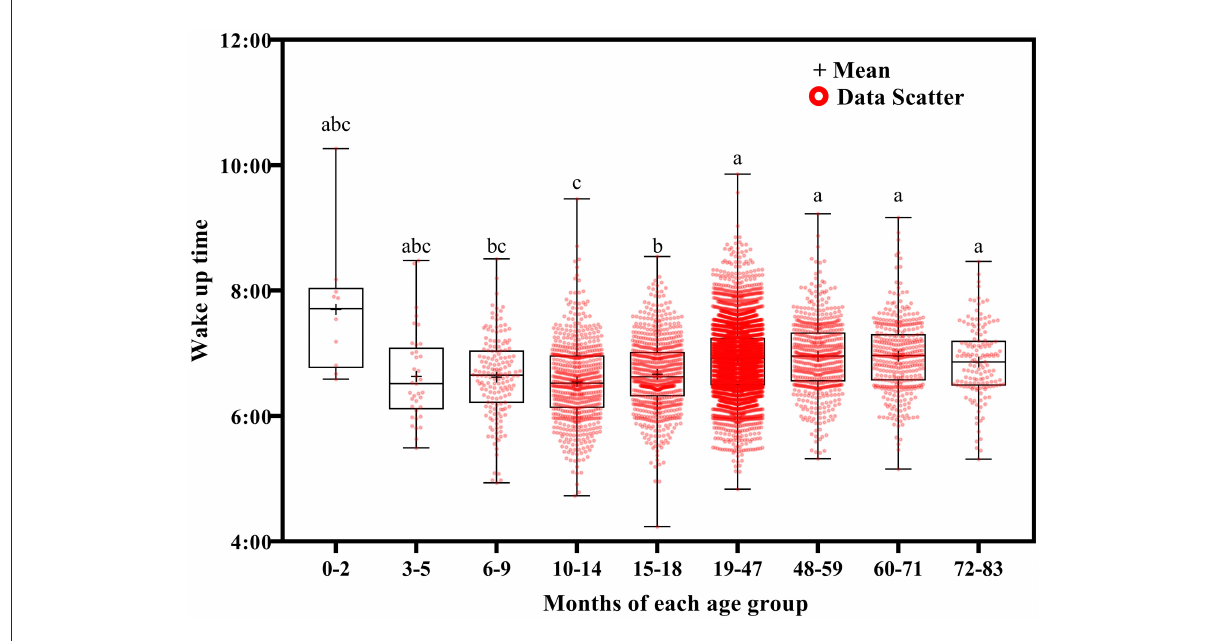
FIGURE2 Results of the one-way ANOVA for wake up time stratified by age.